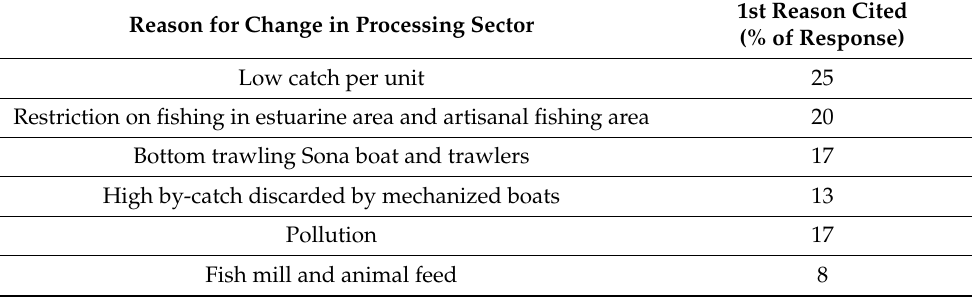
Table 6. Response matrix on reasons for change in dried fish practice mentioned by the respondents ( N = 24).